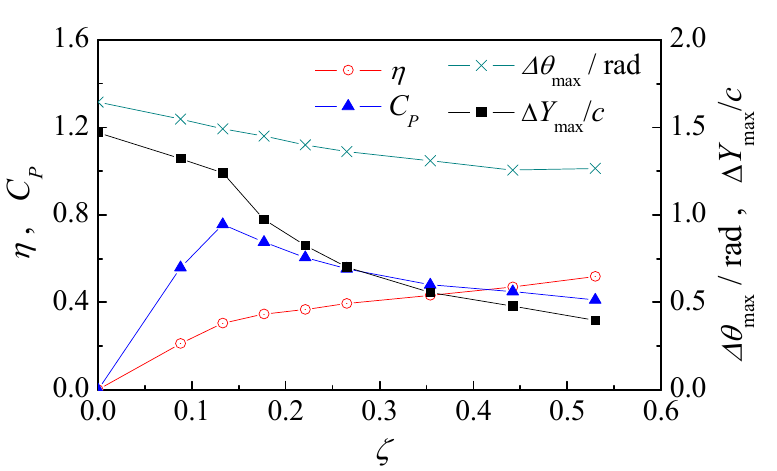
Figure 7. Variation of flapping-hydrofoil performance with different damping coefficients under baseline case.